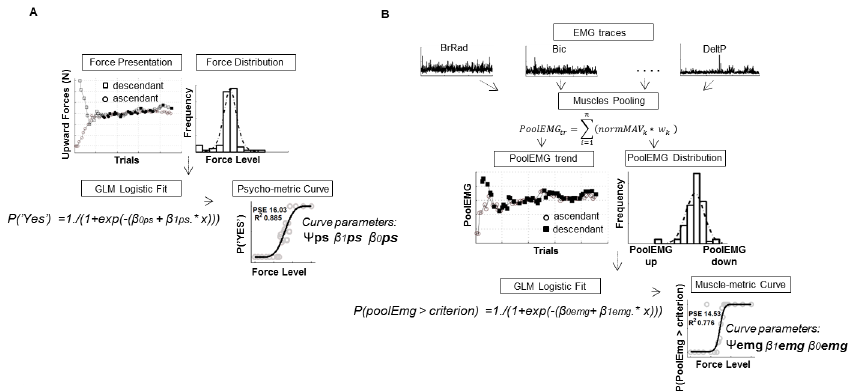
Fig 2. Psycho & Muscle metric curve computation from a typical subject. A) For each subject, the computation of the psychometric curve was obtained by extracting the distribution of the force level explored by the participant during the UP-DOWN staircase adaptive procedure and by fitting a logistic function to the probability of a positive answer with respect to each external force level (x). Ψ ps , β 1ps , β 0ps indicate the absolute threshold (PSE), the slope and the intercept, respectively, characterizing the logistic function that best explains the probability of detecting an upward force given each stimulus force. B) Computation of the muscle-metric curve was obtained by means of a weighted pool of all muscle activity (PoolEMG) and then fitting a logistic function to the probability of a PoolEMG value to be higher than the criterion per each external force level presented (x). Criterion level was set to the mean of the PoolEMG distribution (paragraph 1.4 in S1 Text for details). Ψ emg , β 1emg , β 0emg indicate the absolute threshold (PSE), the slope and the